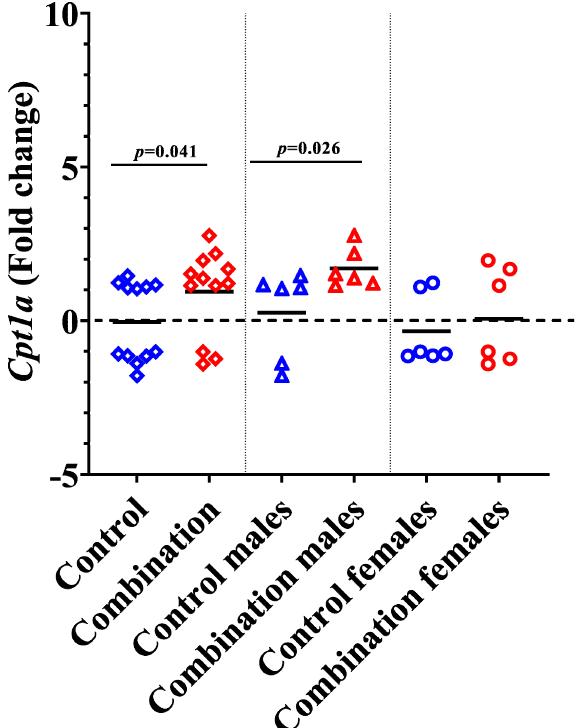
Figure 9. Combination exposed males have increased myocardial expression of Cpt1a . Bars represents mean fold change (n = 12). Blue color indicates controls and red color indicates combination exposed. Bars represent mean fold change and the significance accepted at p < 0.05.